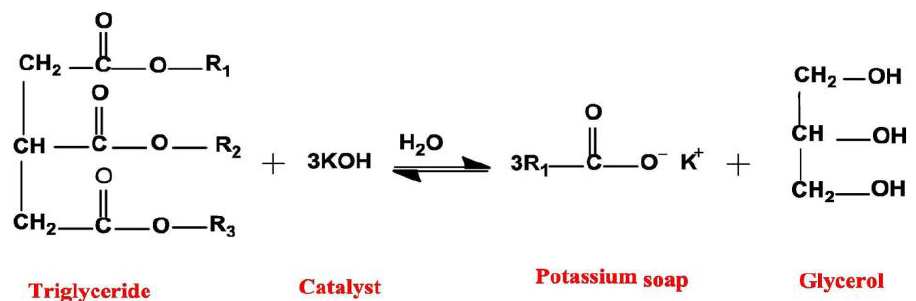
Figure 5. Saponification reaction mechanism. Data adapted from [71], published by Elsevier, 2022.